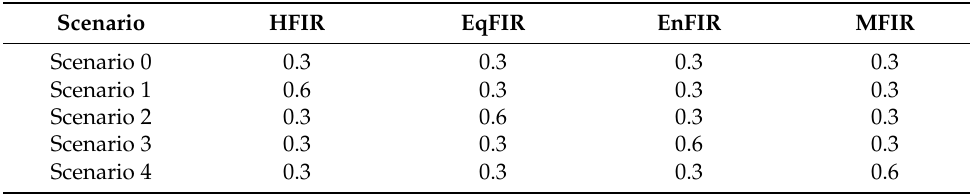
Table 10. Different safety input scenarios.